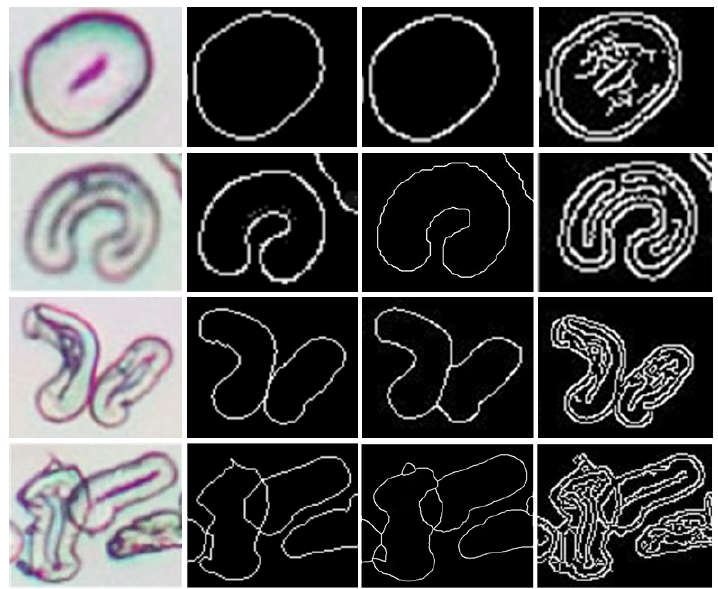
Figure 13. The comparison of edge detection effect between the method in this paper and the method in reference [11]. The first column is the cross-sectional microscopic images of cotton fiber, the second column is the manually labeled edge information, the third column is the edge detection result of the method in this paper, and the fourth column is the edge detection result of the method in reference [11].